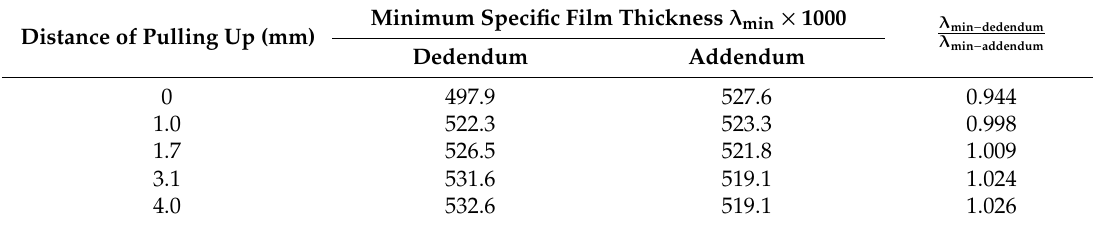
Table 5. Variation of specific film thickness with distance of pulling up